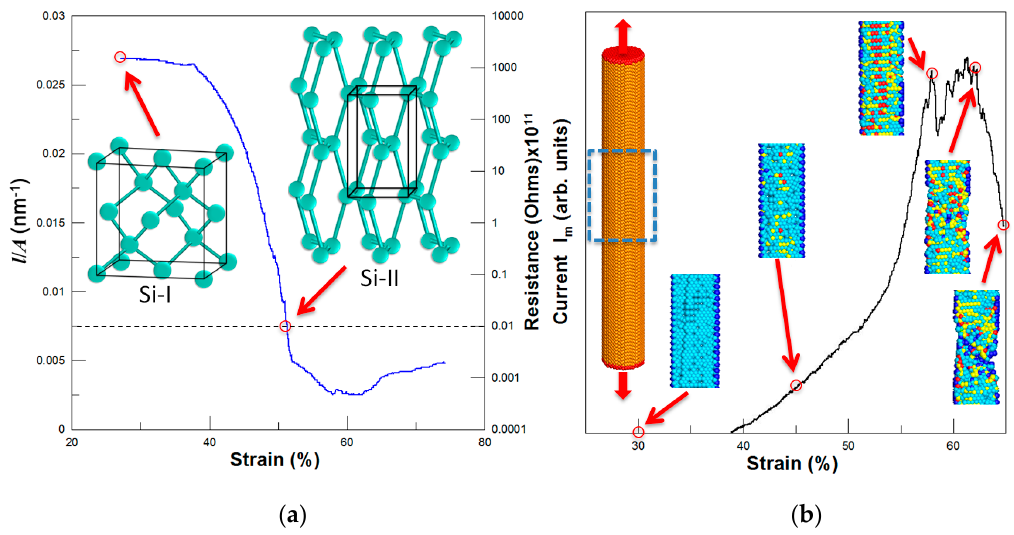
Figure 8. Resistance and current versus tensile strain of SiNW ( a ) resistance-strain curves; ( b ) current-strain curves (blue: incomplete nanostructure with CN < 4; cyan: CN = 5 meta-stable phase with CN = 5; yellow: Si-II phase with CN = 6; red: high-pressure phase with CN > 6).